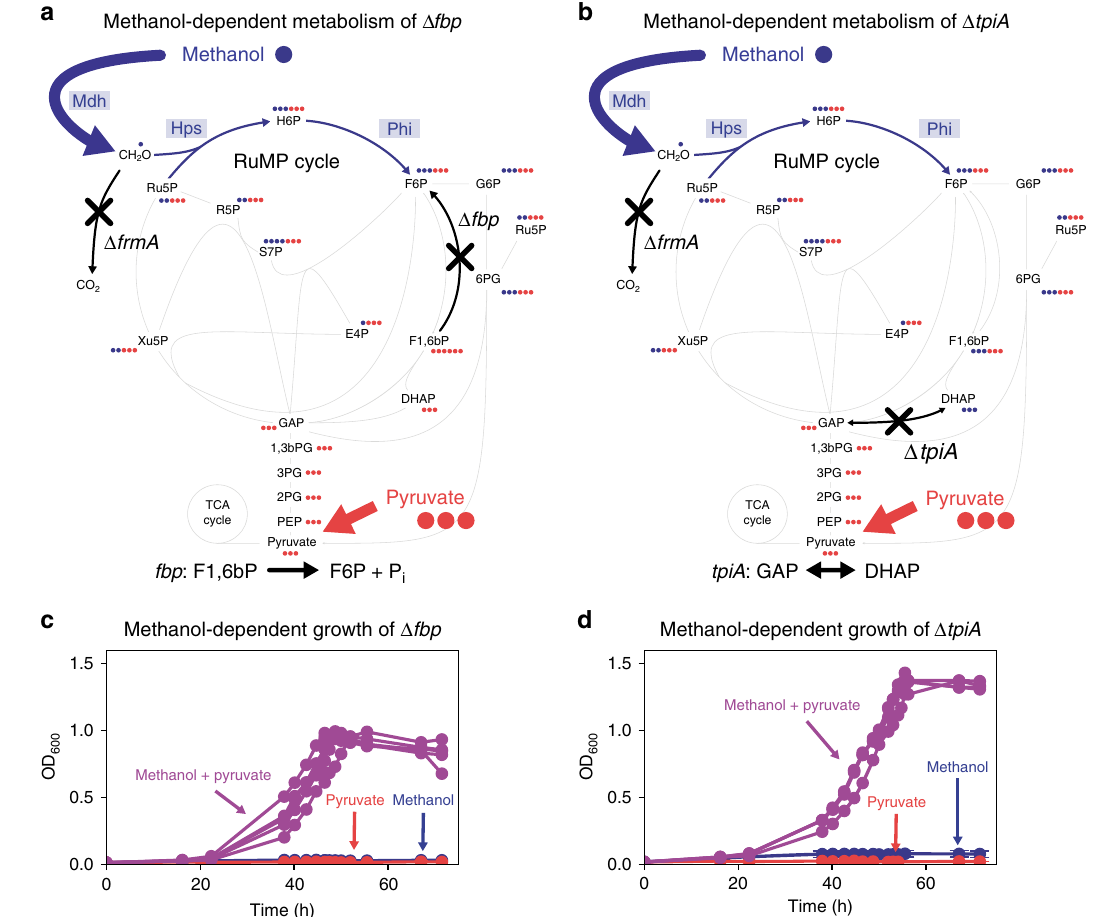
Fig. 3 Experimental investigation of methanol-dependent growth. a, b Central metabolism of the methanol-dependent E. coli strains Δ frmA Δ fbp ( a ) and Δ frmA Δ tpiA ( b ) expressing the RuMP cycle genes mdh , hps and phi . Synthetic pathway reactions and enzymes are depicted in blue, the endogenous metabolic reactions are in gray and gene deletions are in black. The number of dots represents the number of carbons of the speci fi c metabolite and the coloring. The dots are colored according to thepredicted methanol-derived metabolite fraction, whereby the part of the metabolite that stoichiometrically must originate from methanol is illustrated in blue, the one that is produced from pyruvate in red. c, d Methanol-dependent growth of Δ frmA Δ fbp ( c ) ( n = 5) and Δ frmA Δ tpiA ( d ) ( n = 4) expressing Cupriavidus necator mdh 2 CT4-1 from pSEVA424 and Methylobacillus fl agellatus hps and phi from pSEVA131. Methanol-dependent strains were cultivated in minimal medium supplemented with both methanol (500 mM) plus pyruvate (20 mM) (purple), methanol (500 mM) as the sole carbon source (blue) and pyruvate (20 mM) as the sole carbon source (red). The biological replicates in the multi-substrate markers. For abbreviations, see Fig. 1. Source data are provided as a Source Data